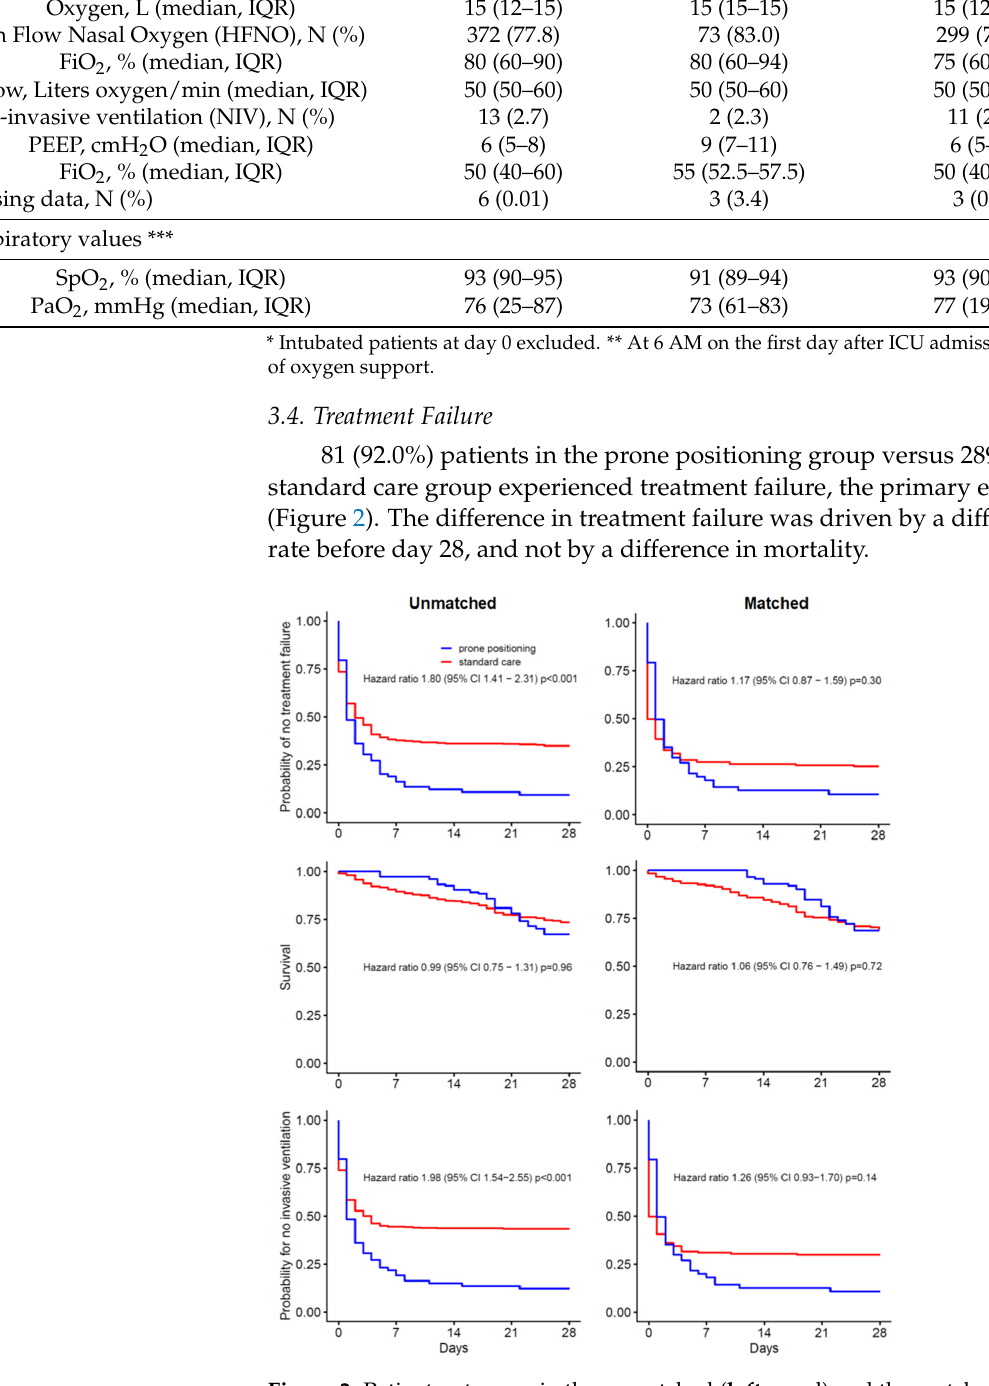
Figure 2. Patient outcomes in the unmatched ( left panel) and the matched analysis ( right panel).